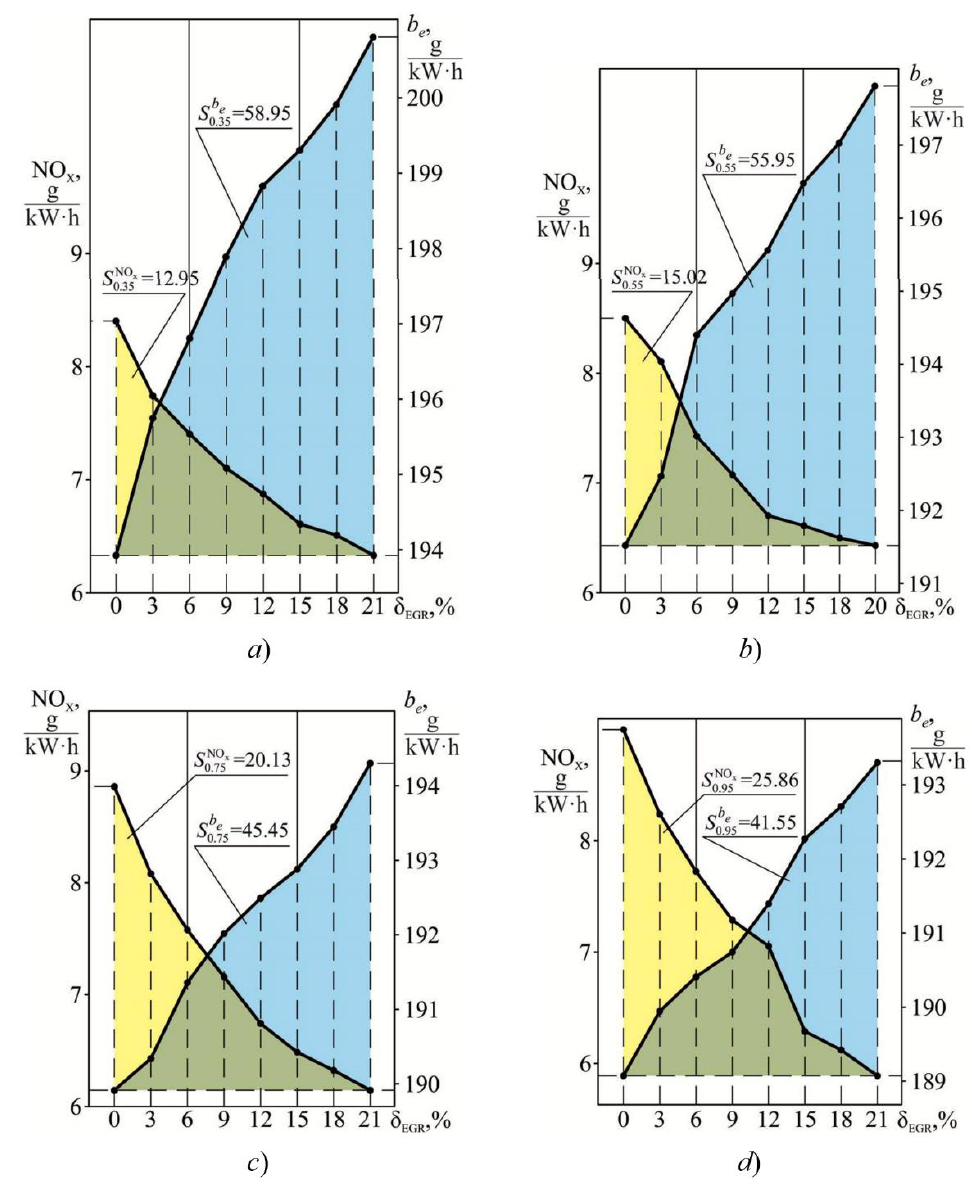
Figure 8. Emission of nitrogen oxides NO X and specific effective fuel consumption of a diesel 16V32 STX-MAN under various conditions of the experiment: ( a ) load 35%; ( b ) load 55%; ( c ) load 75%; ( d ) load 95%.